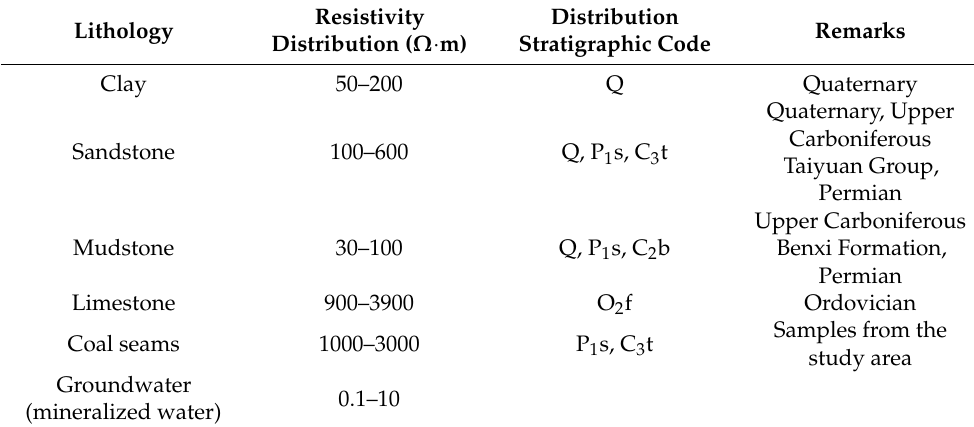
Figure 2. Geological map of two study areas (shown by the green dots). Table 2. Electrical parameters and lithological properties revealed by drilling data.